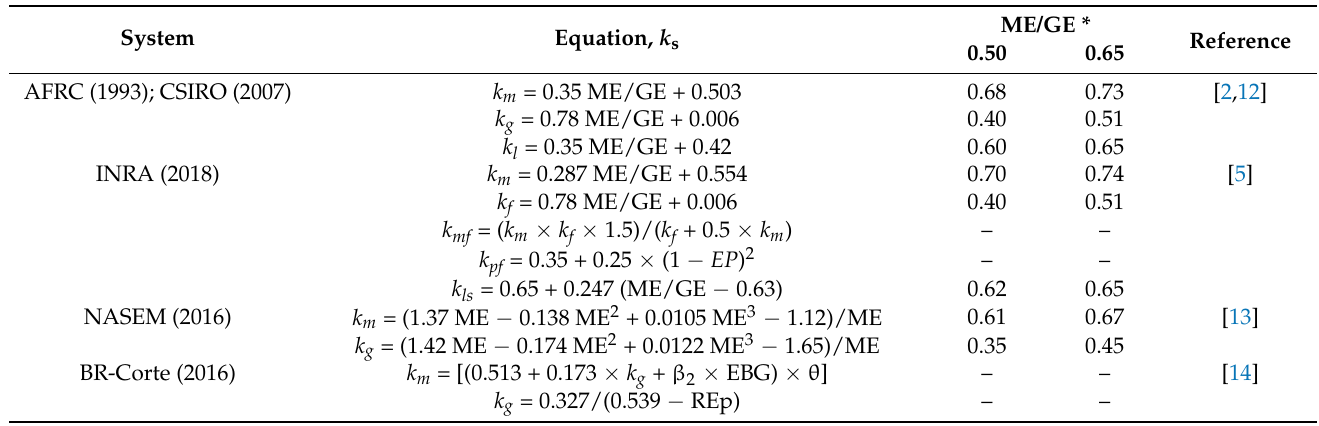
Table A1. Equations used to calculate efficiencies of ME utilisation for maintenance, growth and lactation in global energy system and calculated values at two diet metabolisability values.